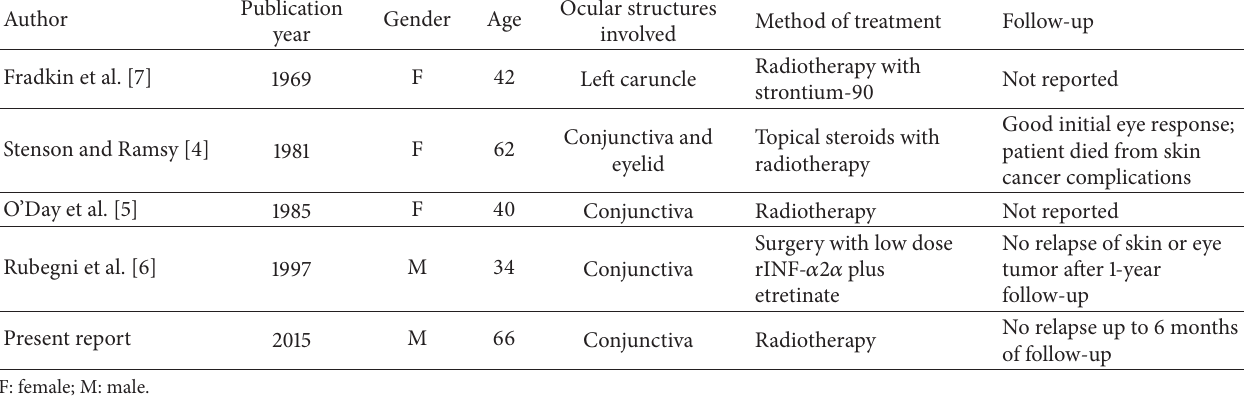
Table 1: Cases of T-cell lymphoma of the conjunctiva in patients with mycosis fungoides in the English literature.